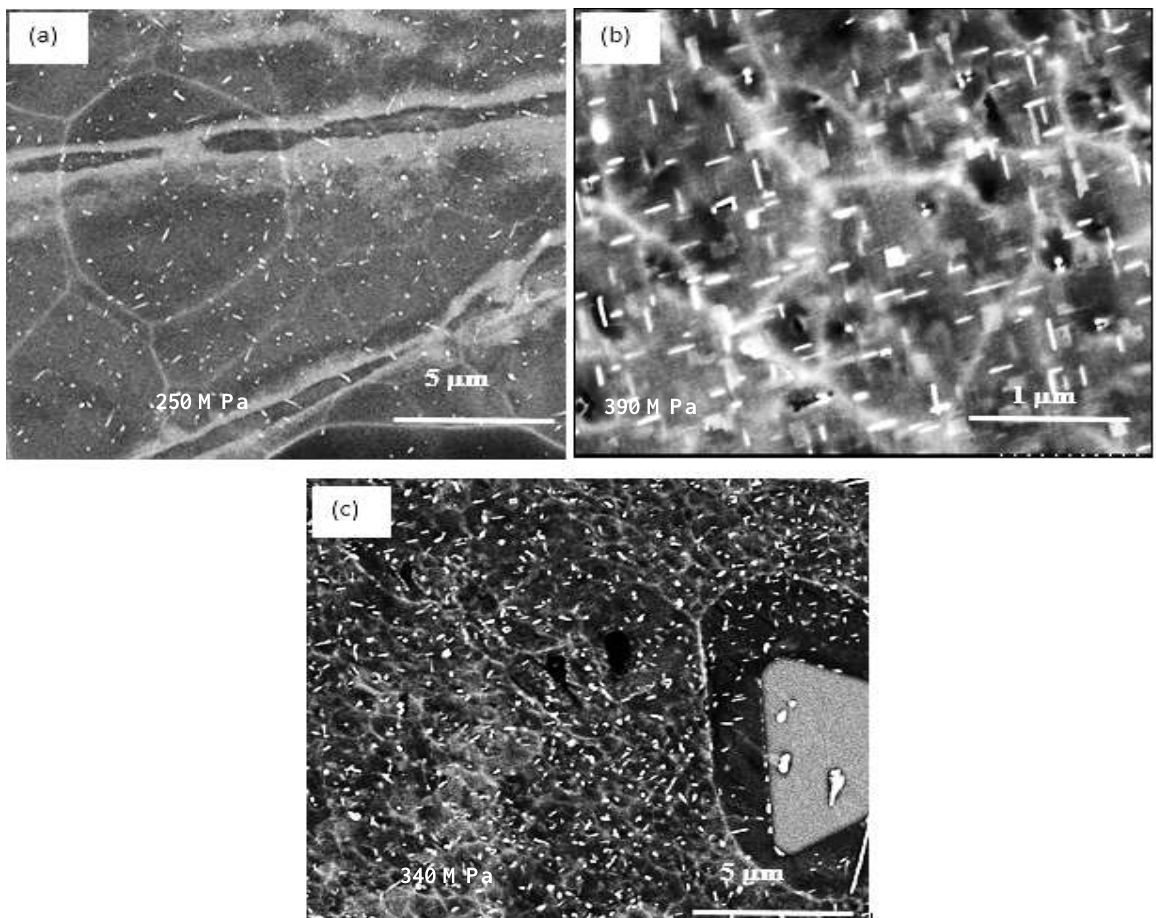
Figure 7. Brightfield TEM images of dislocation-particles in ( a ) T4 and ( b ) T6 conditions, revealing the significant increase in dislocation density—same zone axis [17].